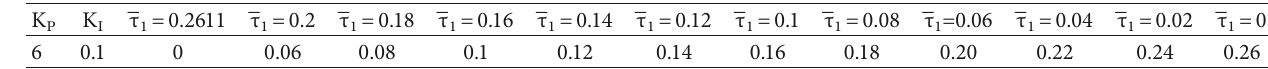
− 4, the highest acceptable delay bound τ ̅ 1